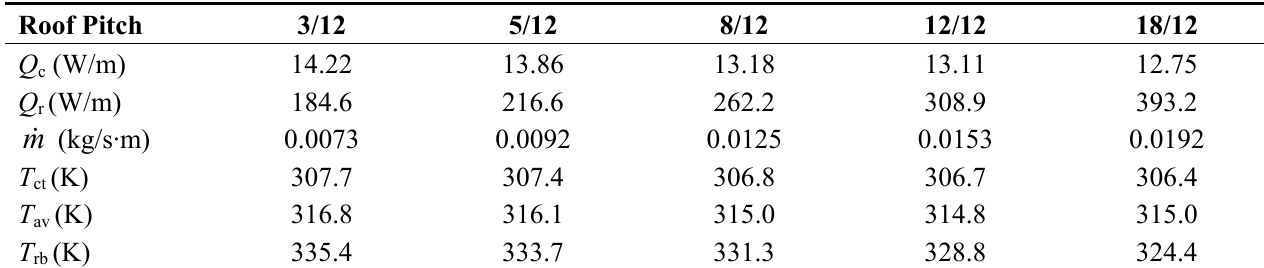
Table 3. Summary of numerical results for R-20 cases.